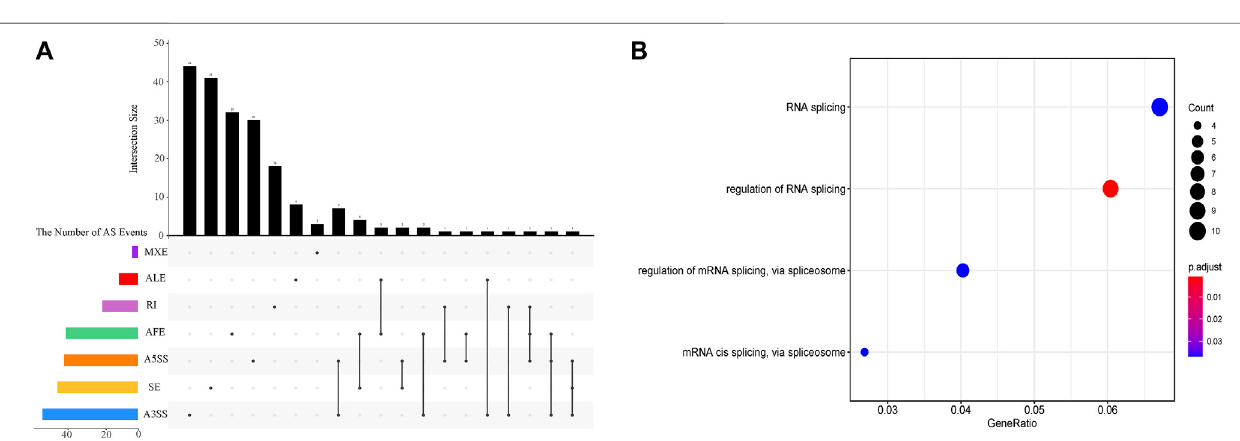
Frontiers in Cell and Developmental Biology |